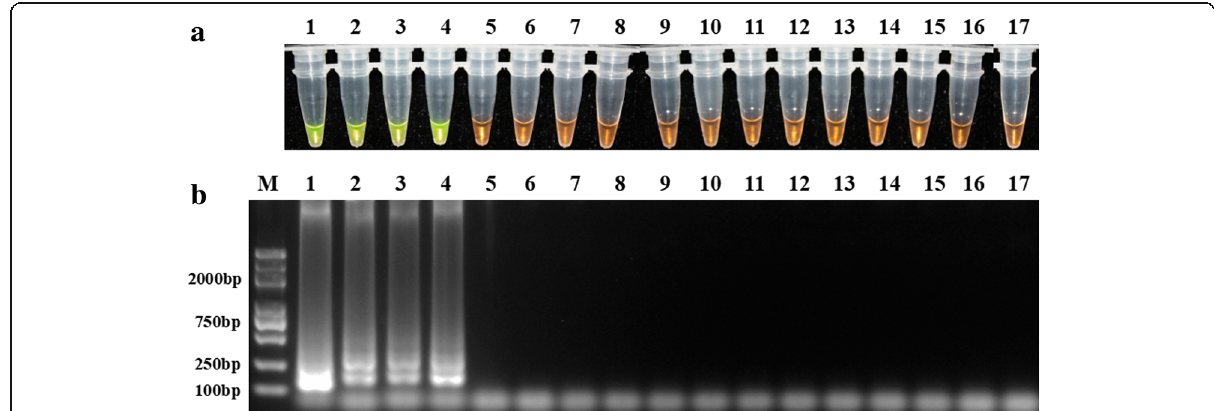
Fig. 5 Conduction of LAMP using mycelia . a LAMP products detected with 1000 × SYBR Green I. b Detection of LAMP products by agarose gel electrophoresis. Lane M: DNA 2 K plus Marker; tubes and lanes 1 – 4: E198V strains; tubes and lanes 5 – 8: E198K strains; tubes and lanes 9 – 12: E198A strains; tubes and lanes 13 – 16: wild type strains; tube and lane 17: ddH 2